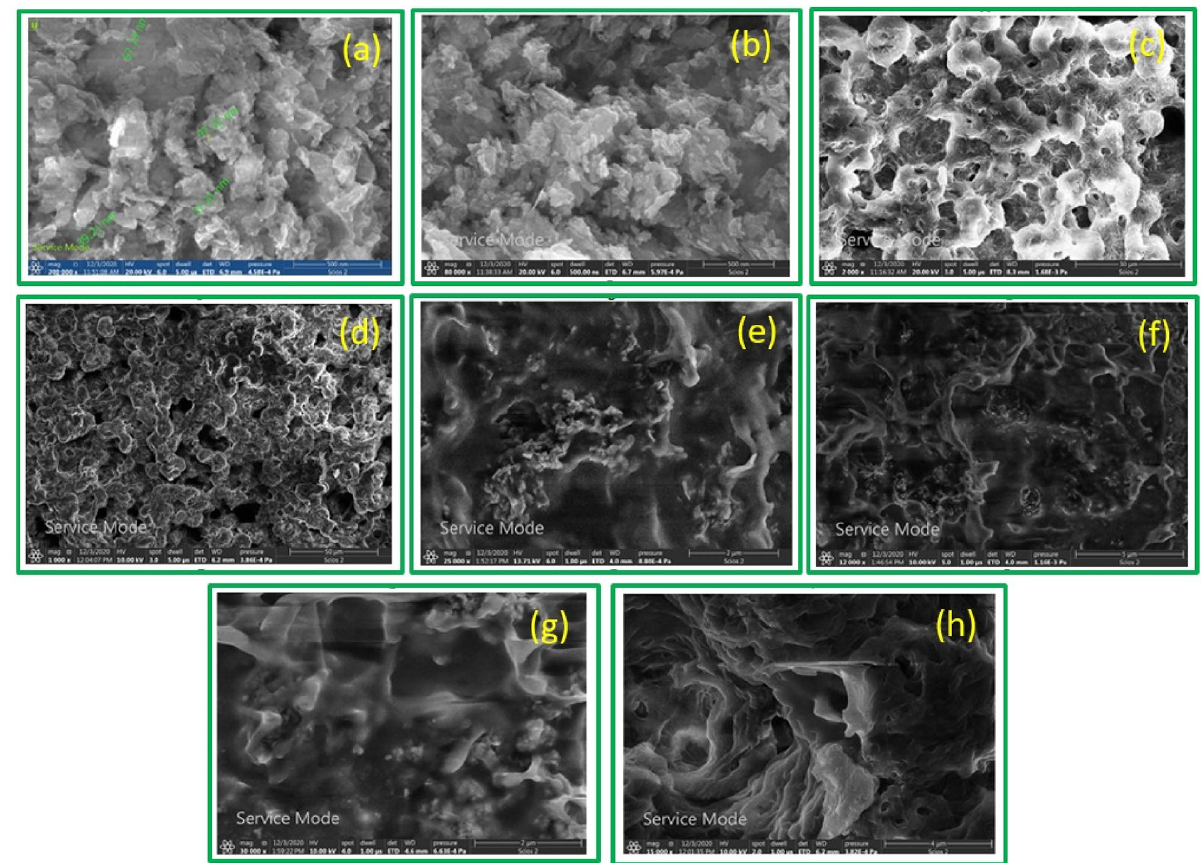
Figure 6. SEM micrographs of Ag–ZnO nanoparticles at magnifications of ( a ) x = 200,000, ( b ) x = 80,000; PHBV/Ag–ZnO